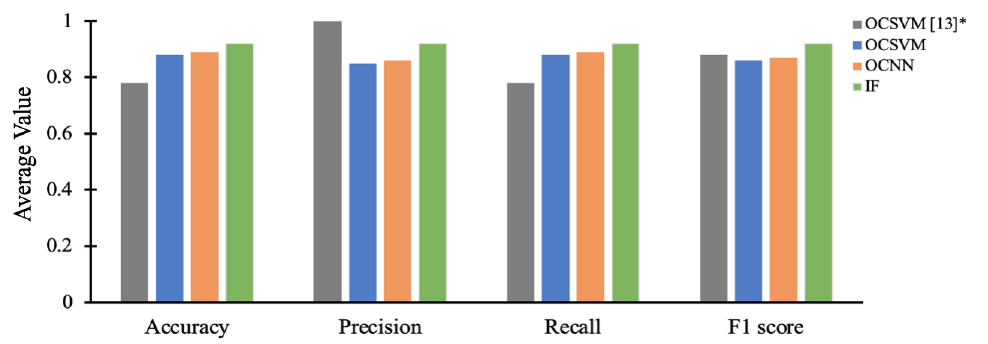
Figure 10. Average test sets 1–3 performance of the OCSVM reported results * in [13], and the OCSVM, OCNN, and IF approaches described in this paper.